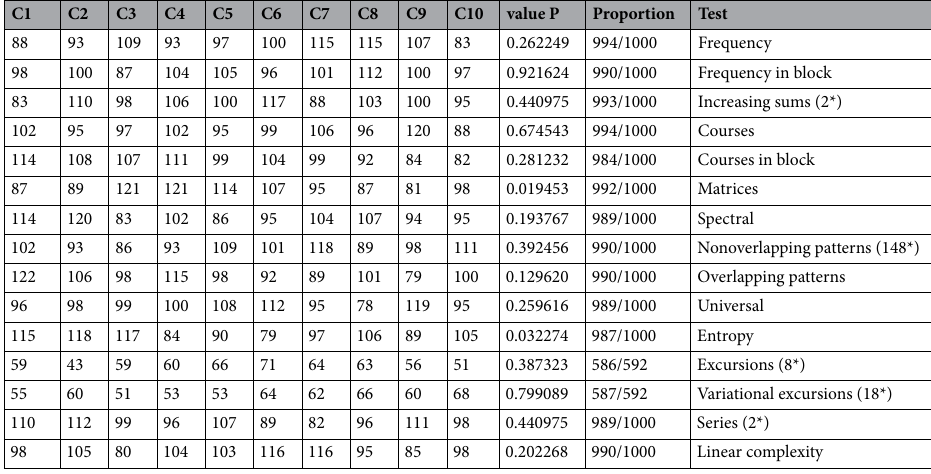
Table 6. pseudorandom generator from Mathematica (sequence 100 MB, tested k = 1000 of sequences, each consistent of n = 800 000 bits).